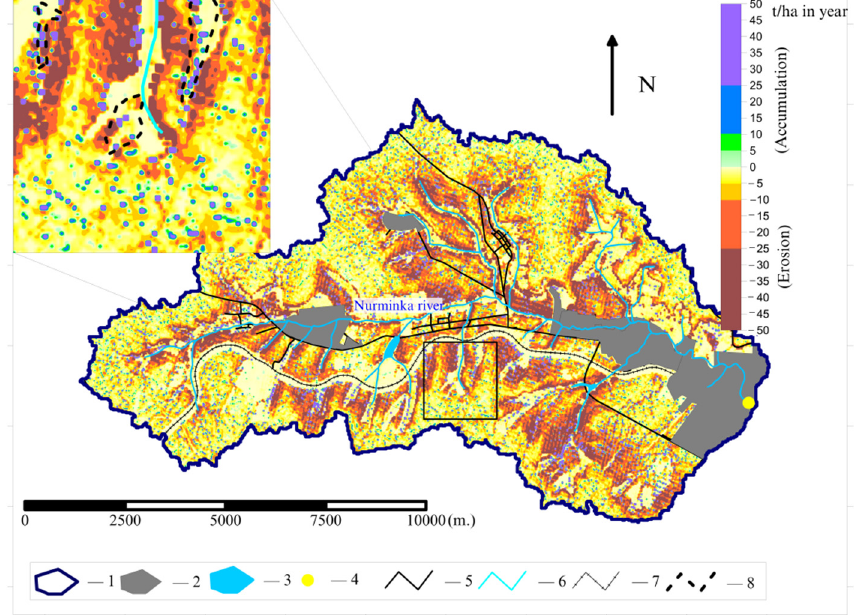
Figure 5. Map of the net water erosion obtained using WATEM/SEDEM methodology for Nurminka river basin (Numbers: 1—river basin boundary, 2—settlements, 3—water bodies, 4—SSY observation station, 5—roads, 6—rivers, 7—railroads, 8—sediment accumulation places within dry valleys and terrace joints).